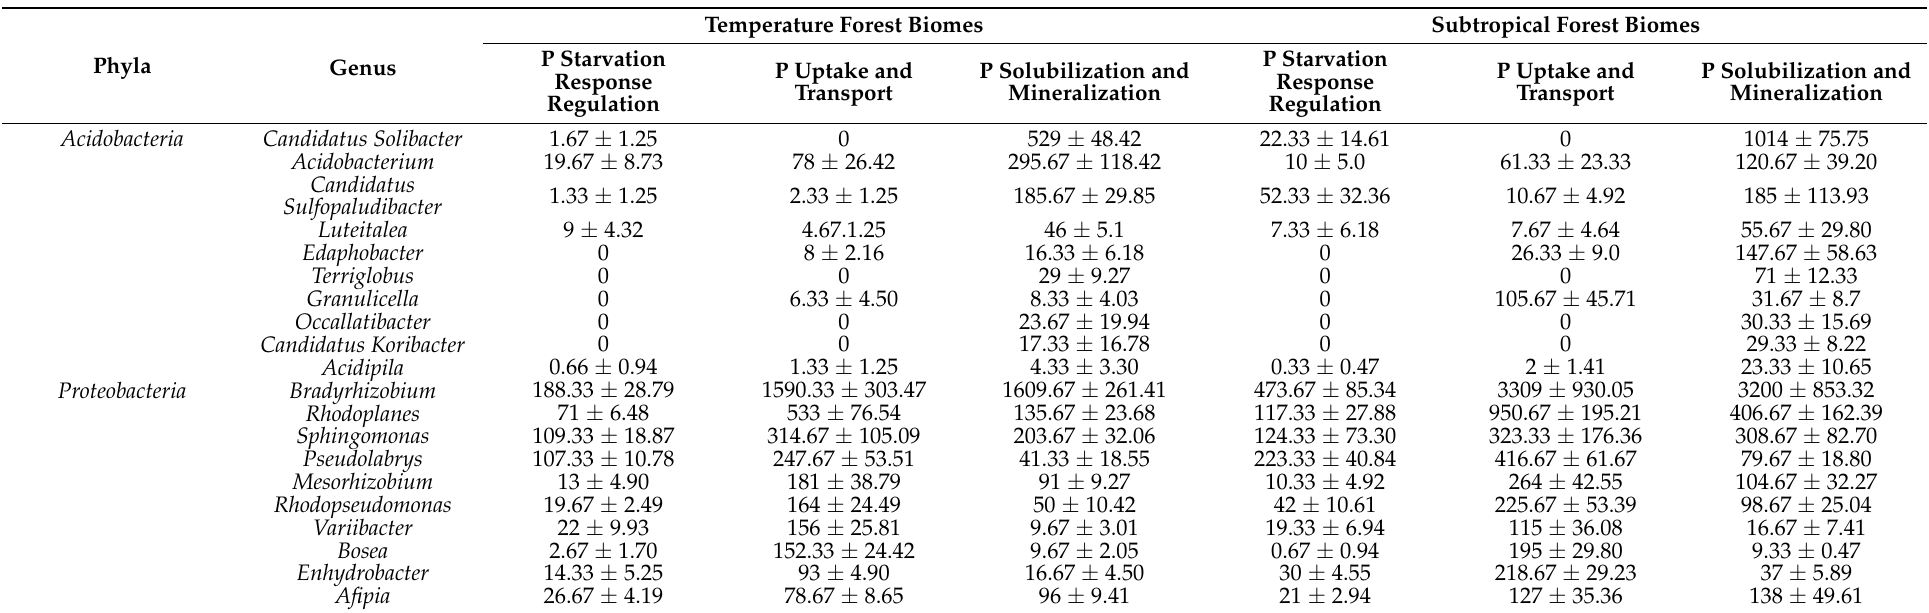
Table 2. Abundance of phosphorus functional genes corresponding to dominant genus (the top 10) of Actinobacteria and Proteobacteria along the subtropical-temperate forest biomes of